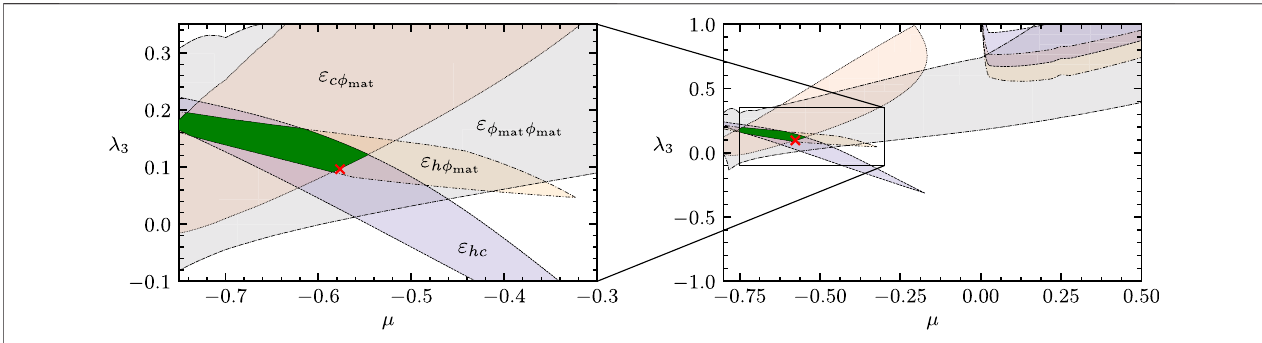
FIGURE 10 | Effective universality of the different avatars of the Newton coupling as a function of µ and λ 3 . The regions of effective universality are de fi ned with ε < 0 . 2 according to 109 . The red cross indicates the UV fi xed point, which lies in the region of effective universality. The fi gure is taken from 203. ij